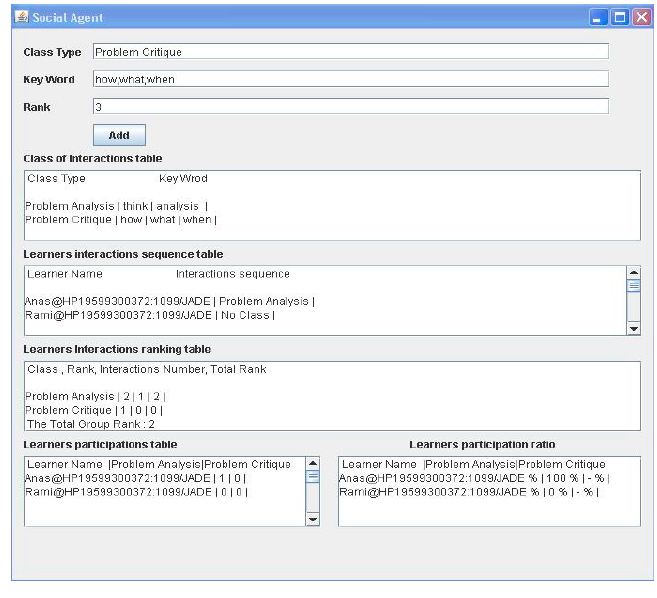
Figure 17. GUI of the social agent.